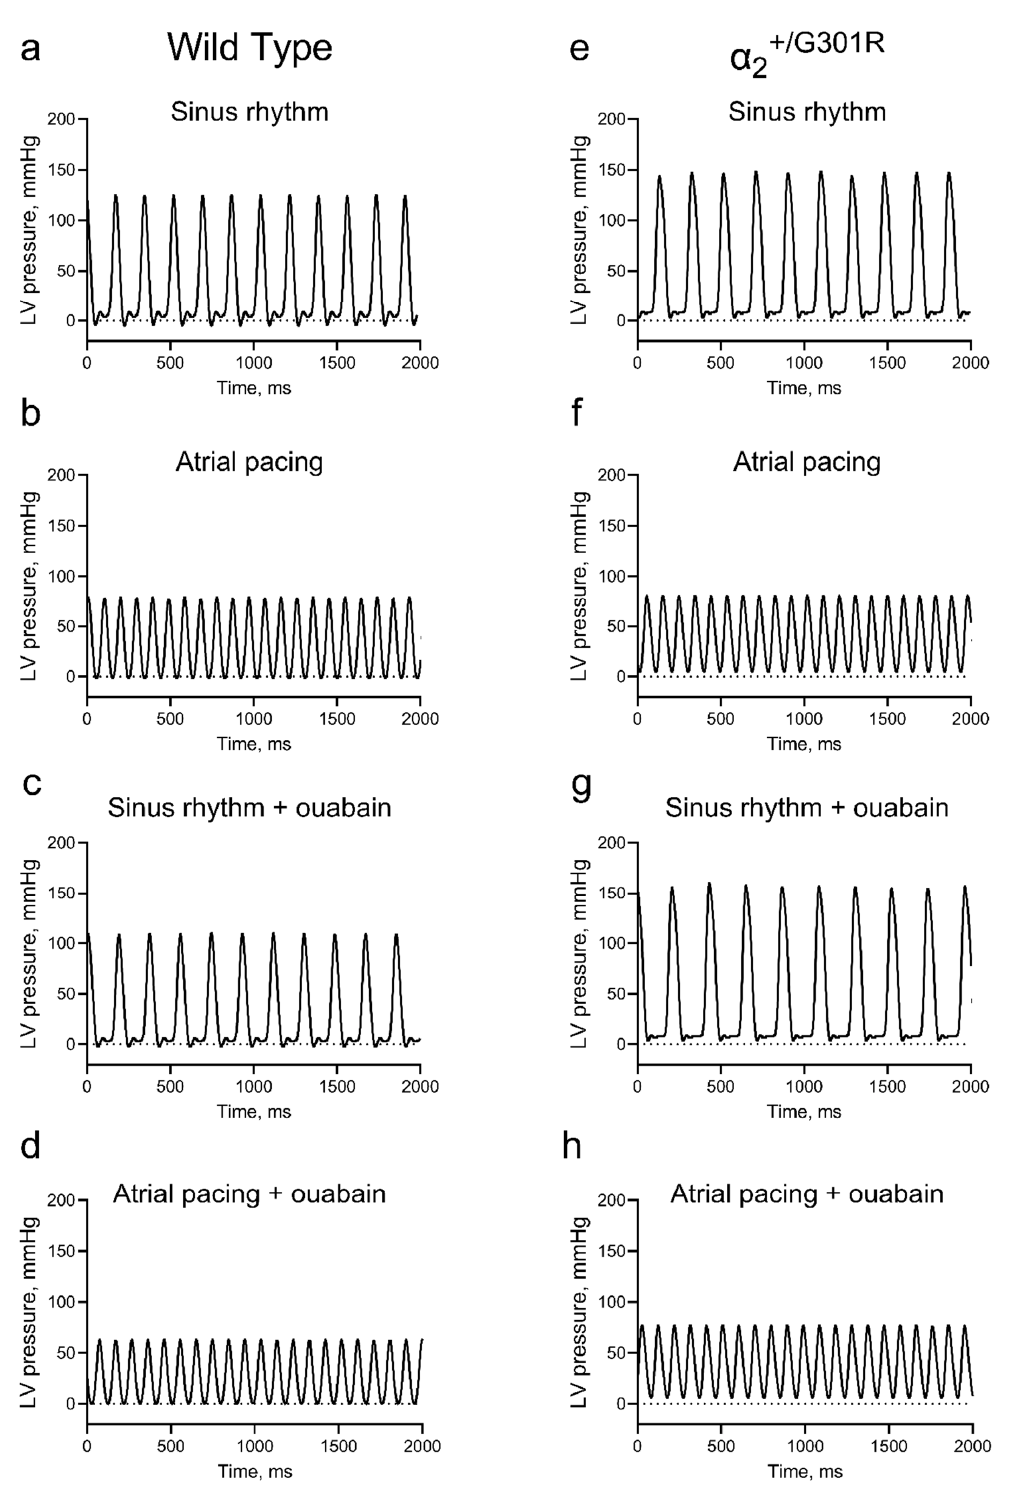
Figure 2. Representative traces of left-ventricular-pressure development of the isolated α 2+/G301R and wild-type (WT) hearts. The left ventricular (LV) pressure waveforms of isolated hearts from WT mice were assessed during ( a ) sinus rhythm in the absence of ouabain, ( b ) pacing at 10.5 Hz (630 BPM), ( c ) sinus rhythm in the presence of ouabain, and ( d ) pacing at 10.5 Hz in the presence of ouabain. Similarly, the LV pressure waveforms of isolated hearts from α 2 +/G301R mice were assessed during ( e ) sinus rhythm, ( f ) pacing at 10.5 Hz, ( g ) sinus rhythm in the presence of ouabain, and ( h ) pacing at 10.5 Hz in the presence of